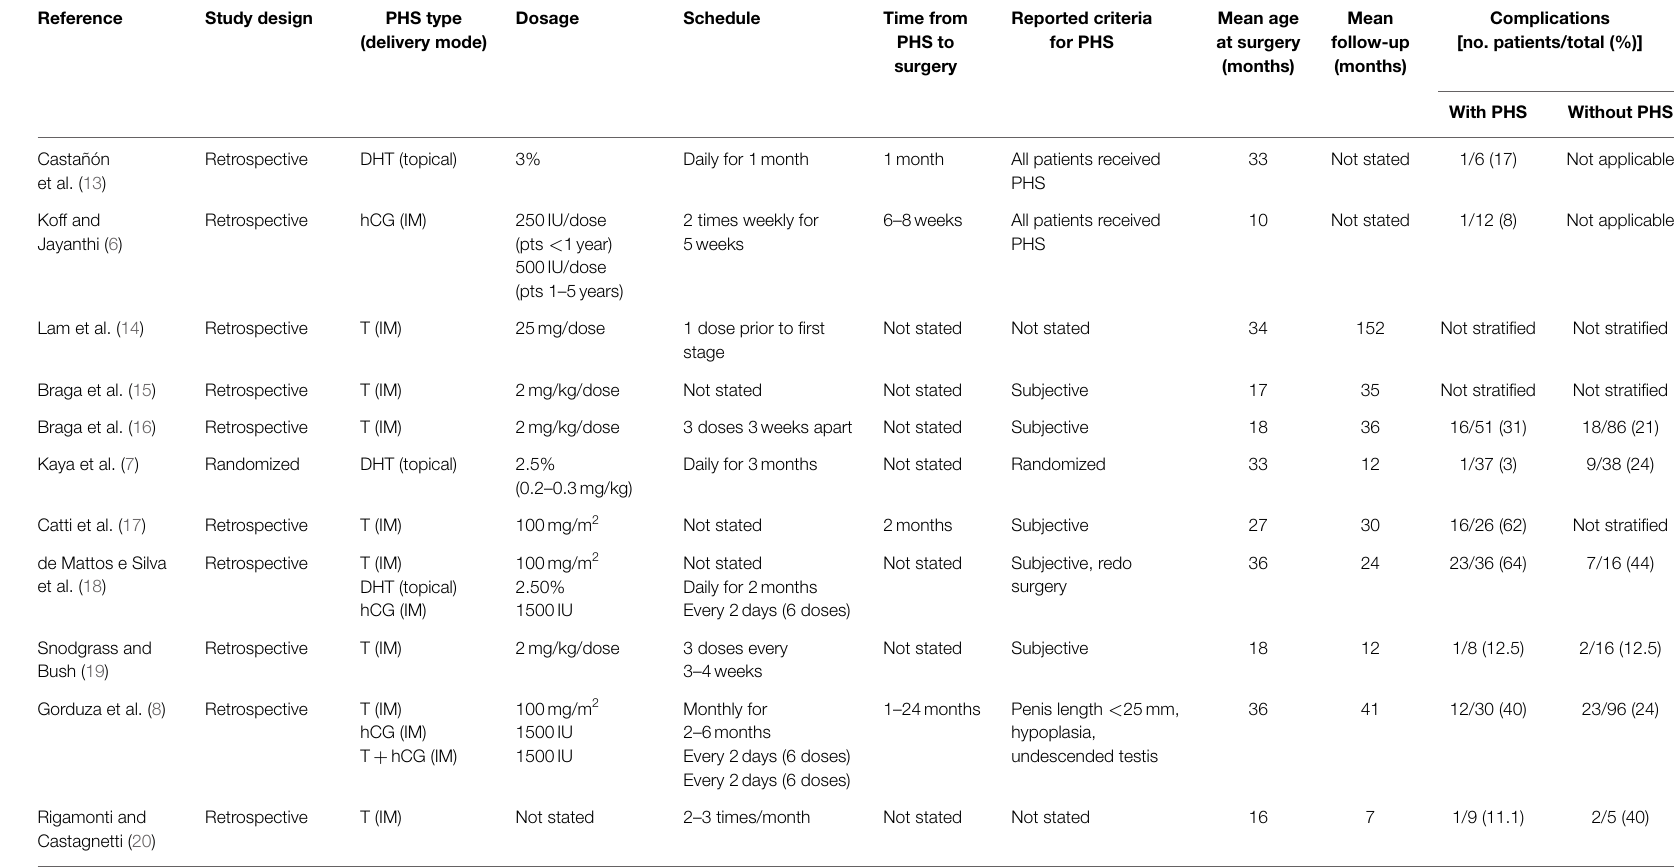
TABLE 1 | Hormone regimen, study demographics, and complication rates with and without pre-operative hormonal stimulation